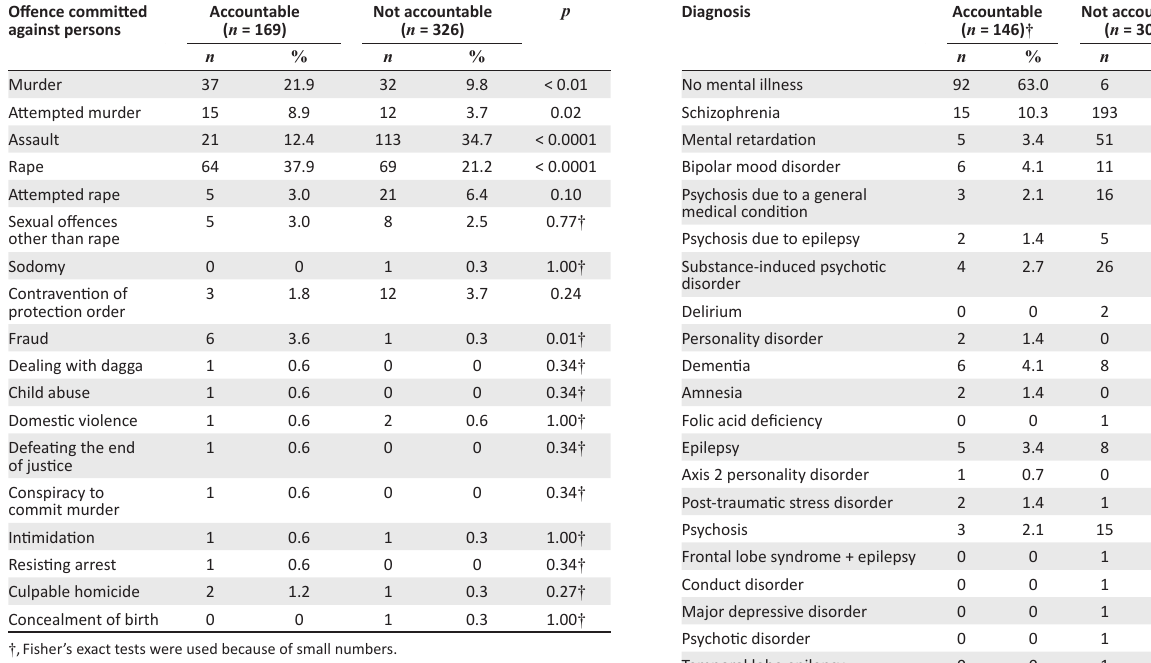
Offence committed against